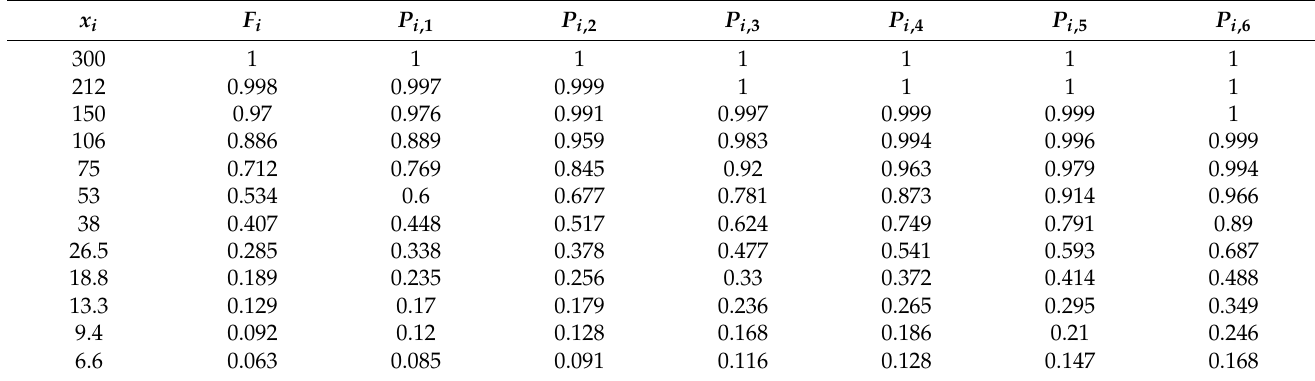
Table 3. Particle size distributions of feed and product for Run 1, x in microns, t = 15, 30, 60, 90, 120, 150